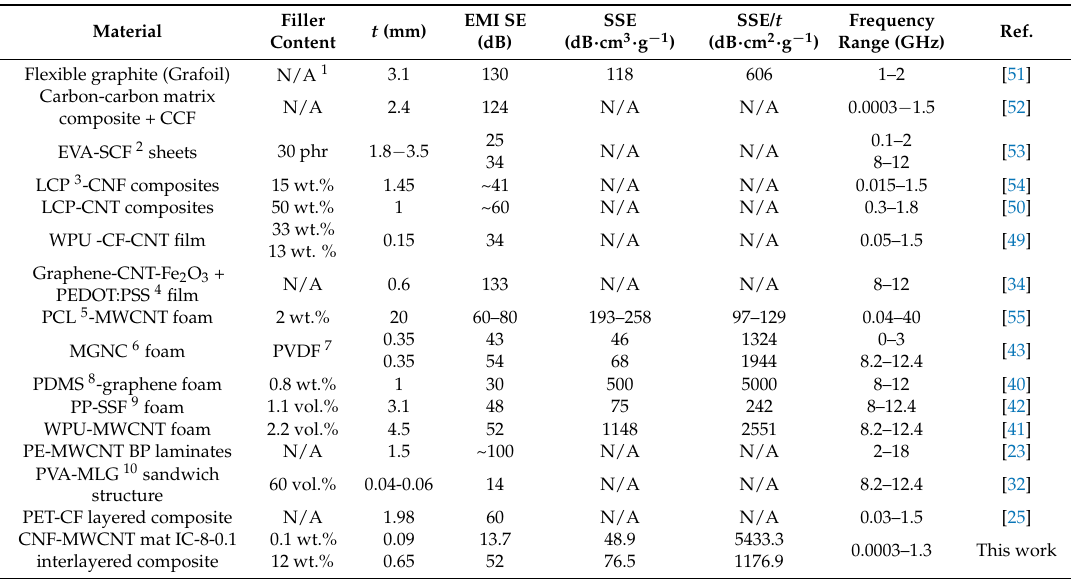
Table 4. Comparison of reported values of EMI SE, SSE, and SSE/ t for different composites and the developed materials in this